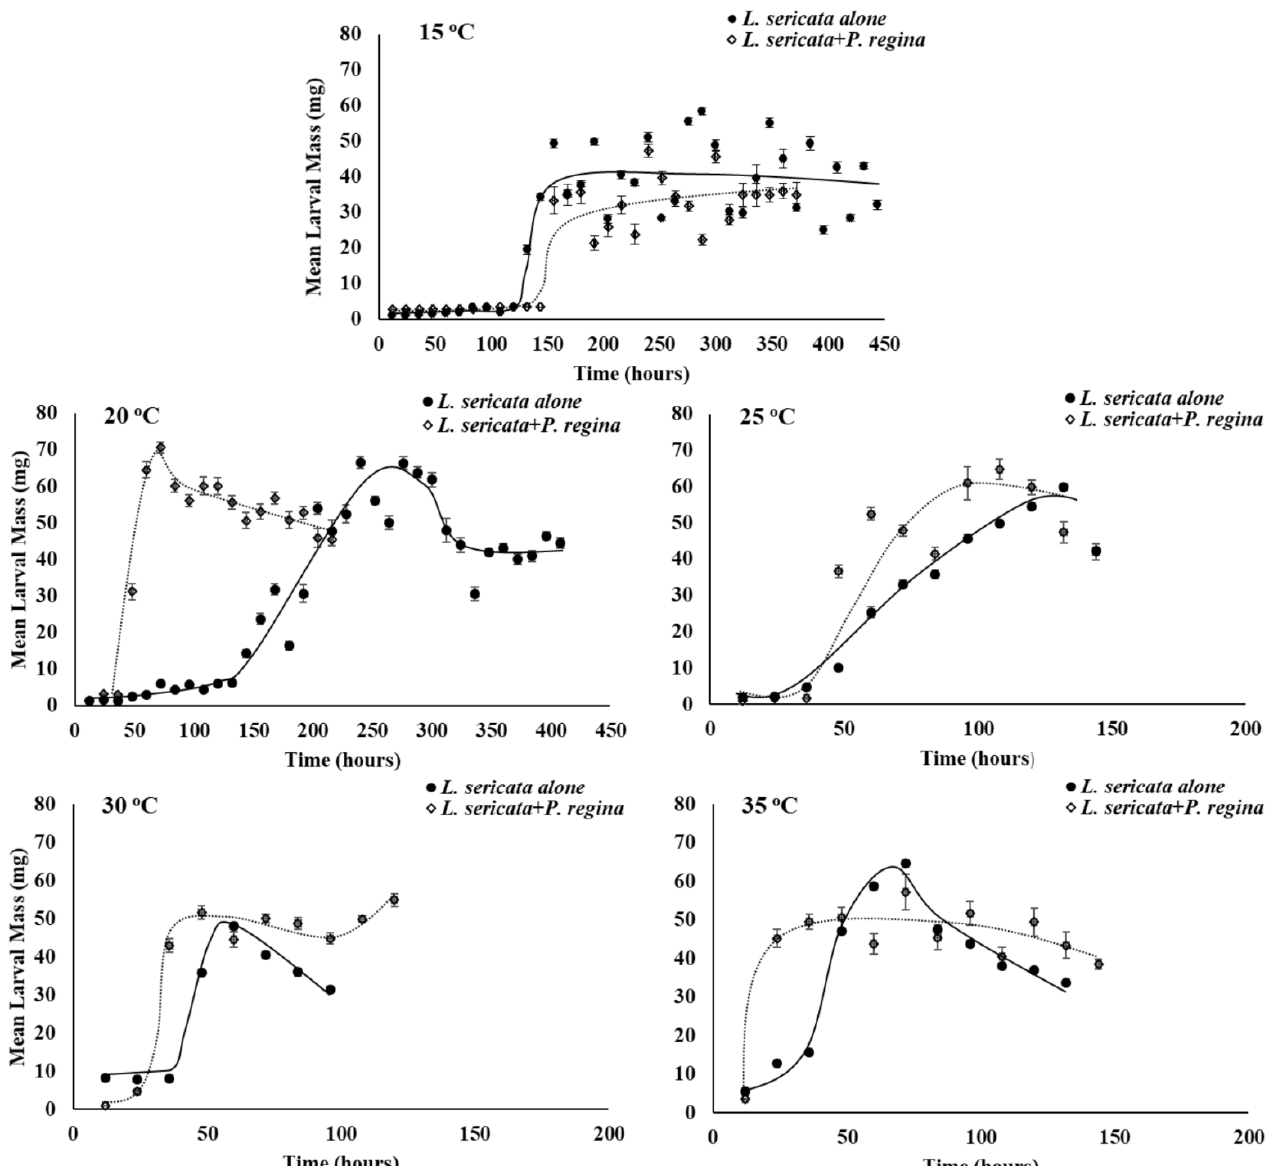
Figure 1. Mean (±SE) larval growth rate (mg/time) of L. sericata larvae reared with conspecifics, or reared with P. regina larvae at various temperatures. Indicator variable linear regression with interaction was conducted on the product of larval mass (mg) and time (in h) over time (not shown) for each species treatment and temperature combination. Slope (growth rate) differs at 30 °C (r 2 = 0.96, F 1,14 = 4.6, p = 0.05). Overall growth rate differs at 20 and 30 °C (r 2 = 0.86, F 1,48 = 6.7, p = 0.01; r 2 = 0.96, F 1,14 = 10.8, p = 0.005, respectively).